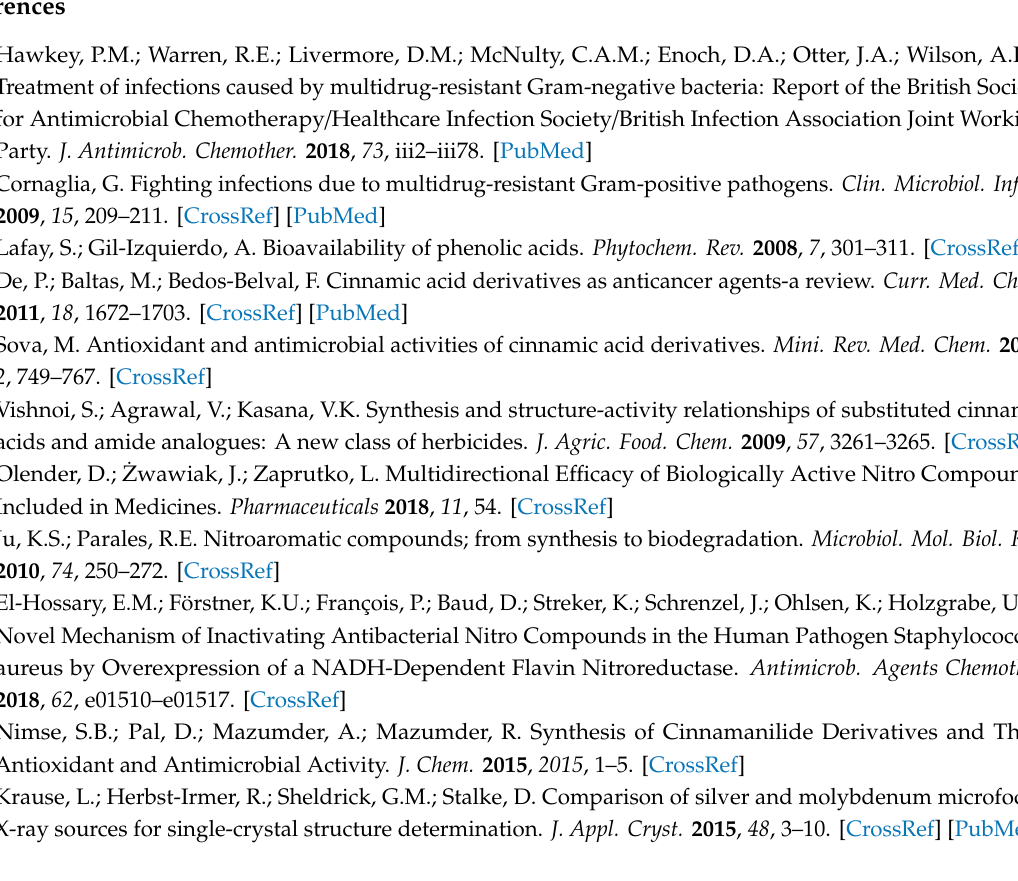
Figure S1: 1 H NMR spectra of compound 1, Figure S2: 13 C NMR spectra of compound 1, Figure S3: Mass spectra of compound 1, UV absorbance spectra of compound 1, Table S1: Calculated inter-molecular potentials energies obtained by UNI forcfield calculations. The supplementary crystallographic data (CCDC 1965718) for the compound 1 can be obtained free of charge from The Cambridge Crystallographic Data Centre via